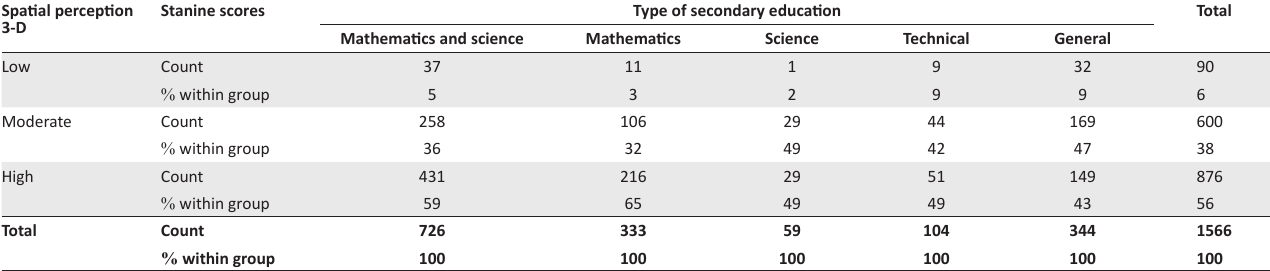
TABLE 6: Contingency table of observed frequencies for the spatial perception 3-D sub-test. Spatial perception